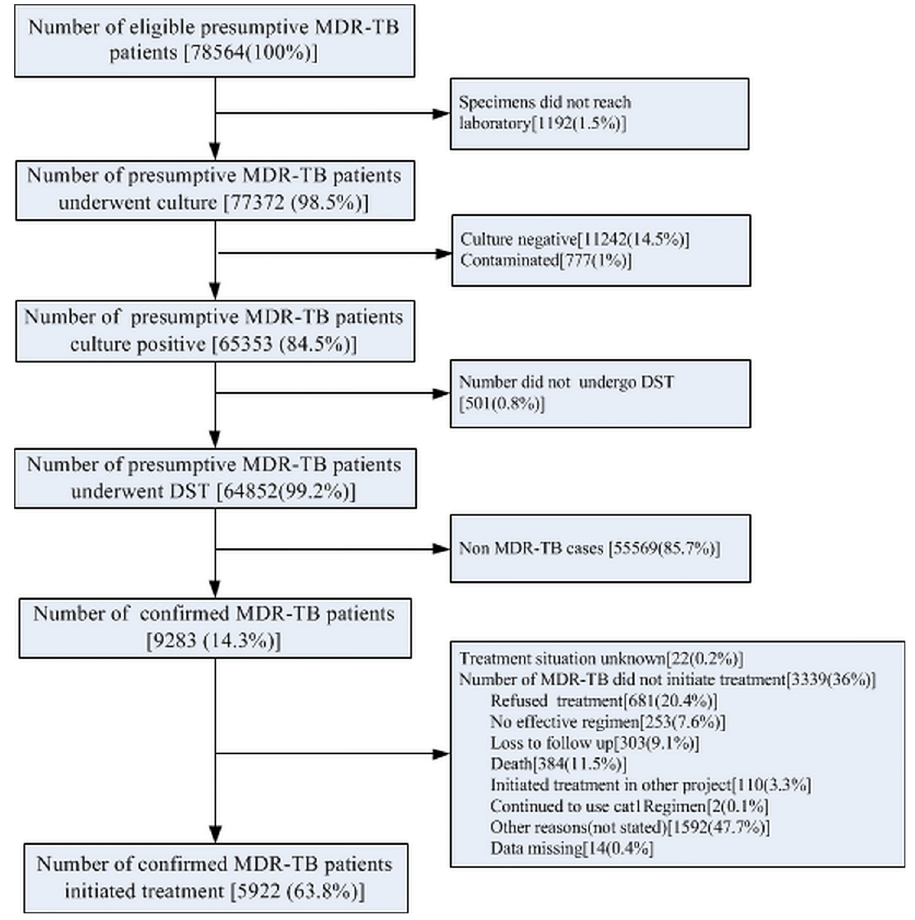
Fig 1. MDR-TB diagnosis and treatment under GFPMDT project in China during October 2006 to December 2013. GFPMDT-Global Fund Programmatic Management of drug resistant tuberculosis;MDR-TB: Multi drug- resistant